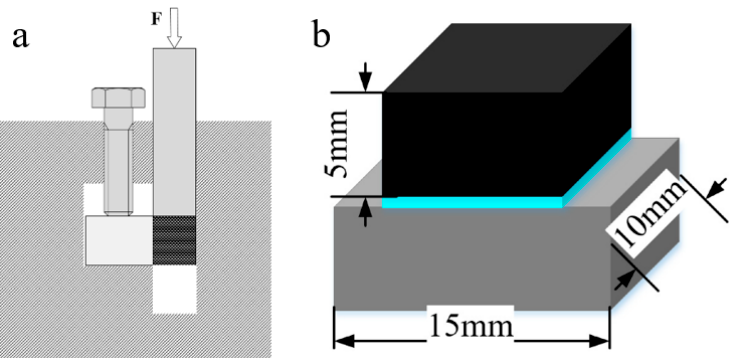
Figure 2. ( a ) Schematic of shear test setup ( b ) Geometry of shear sample of brazed